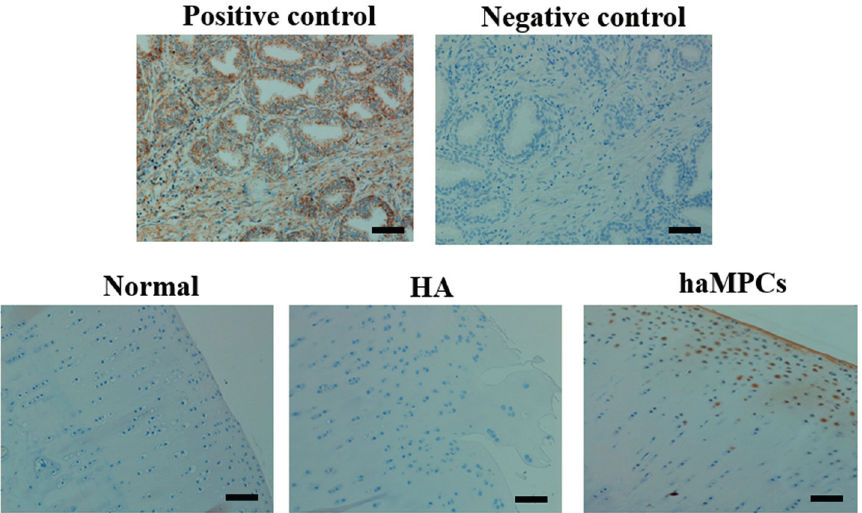
Figure 6. haMPCs engrafted into rabbit cartilage. In normal and HA treated cartilage, human mitochondrial signal was negative. In haMPC group, human cells were engrafted into rabbit cartilage. Immunohistochemical staining in human prostate tissue was used as positive control and negative (isotype) control. Scale bars = 50 μ